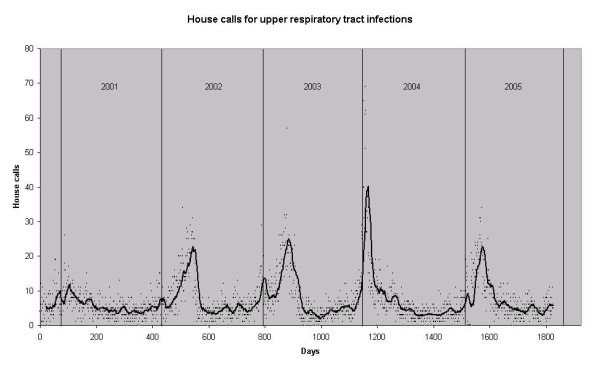
House calls for upper respiratory tract infections.